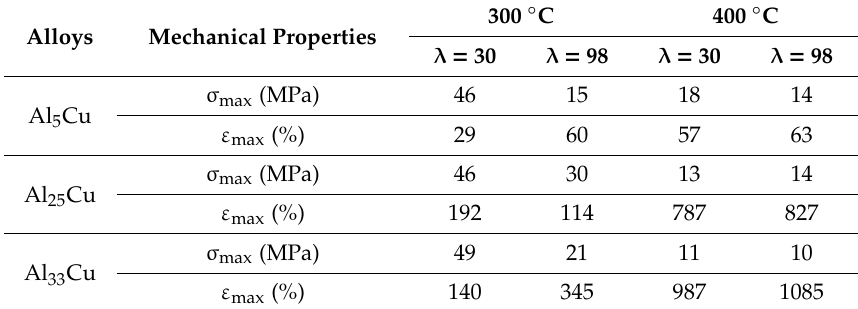
Table 2. Measured mechanical parameters: stress peak ( σ max ), elongation to failure ( ε max ) of deformed Al–Cu alloys.